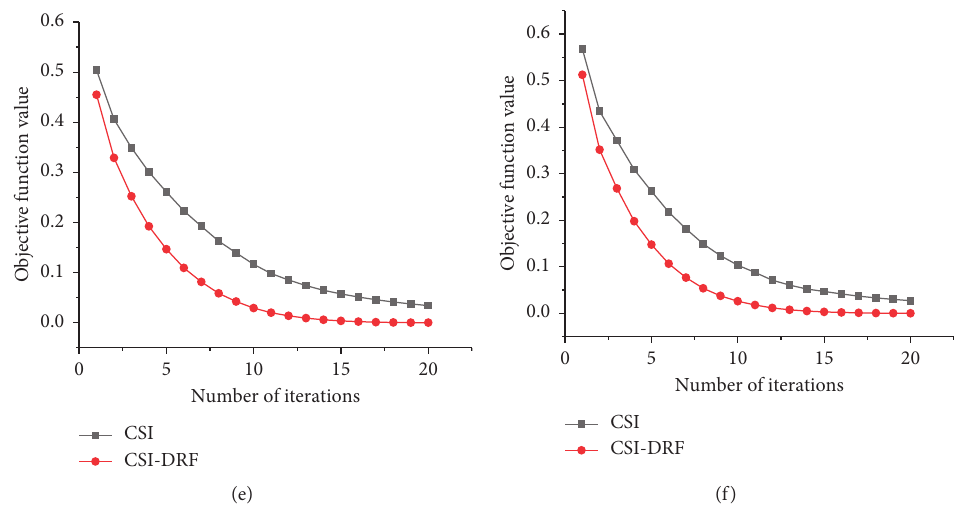
Figure 24: The comparison of convergence curves between CSI and CSI-DRF. (a) The comparison result of “ U -shaped groove.” (b) The comparison result of “two scatterers (asymmetric).” (c) The comparison result of “two scatterers (symmetry).” (d) The comparison result of “single scatterer (TE wave).” (e) The comparison result of “double scatterers.” (f) The comparison result of “single